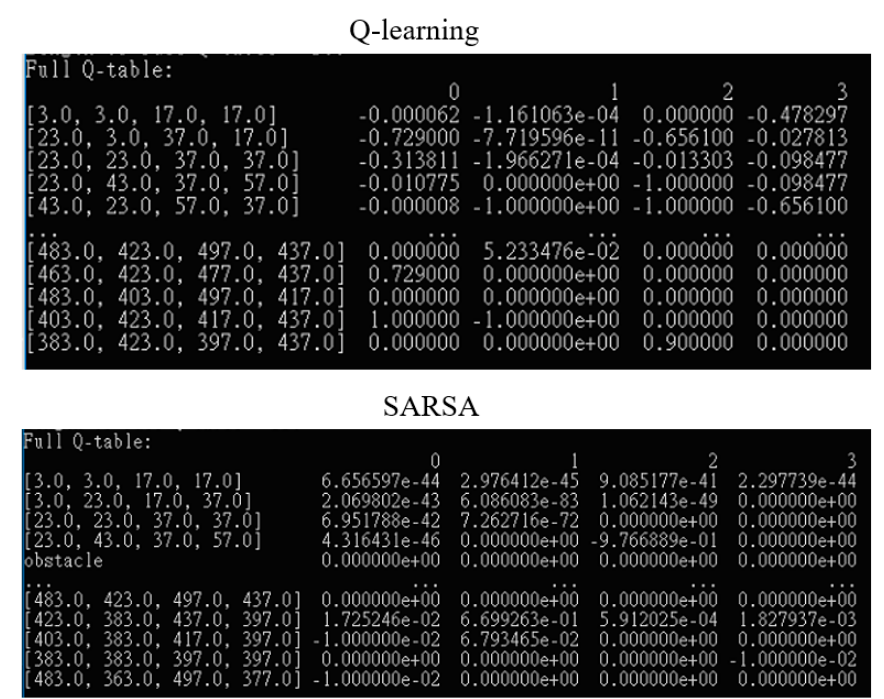
Figure 29. Training results of Q-learning and SARSA in Environment 2.